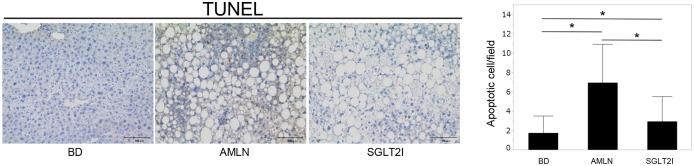
Ipragliflozin improved liver inflammation and suppressed hepatocyte apoptosis.TUNEL-stained paraffin-embedded sections of liver tissue from BD, AMLN, and SGLT2I mice. Magnification, 400×. Scale bars: 100 μm. The number of apoptotic cells per field was counted in BD, AMLN, and SGLT2I mice (n = 5–8). Results are the mean ± SD. Significance was determined using the Student’s t-test (*p<0.05).